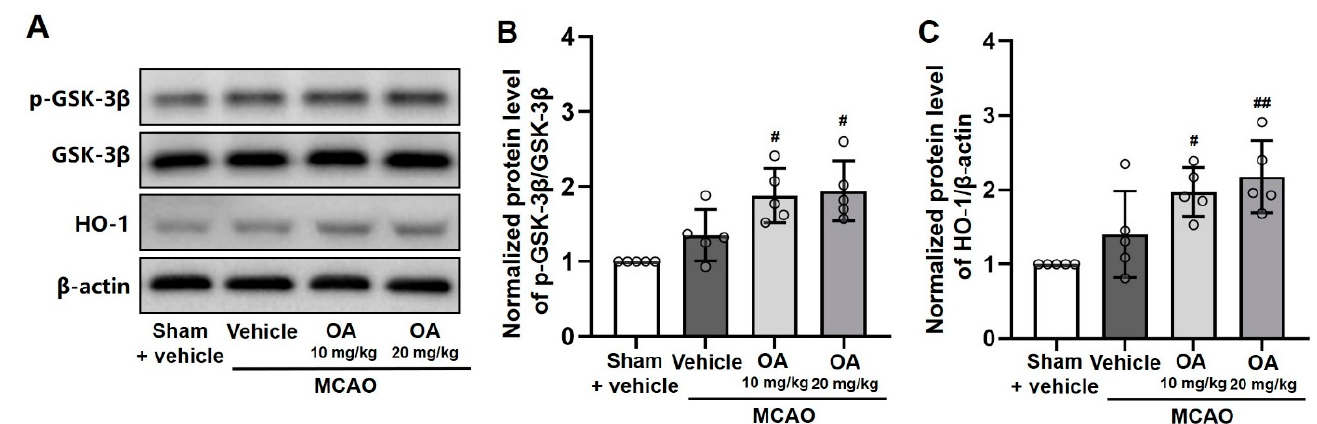
Figure 5. OA administration regulated GSK-3 β /HO-1 signaling pathway. ( A ) Representative protein bands and quantita-